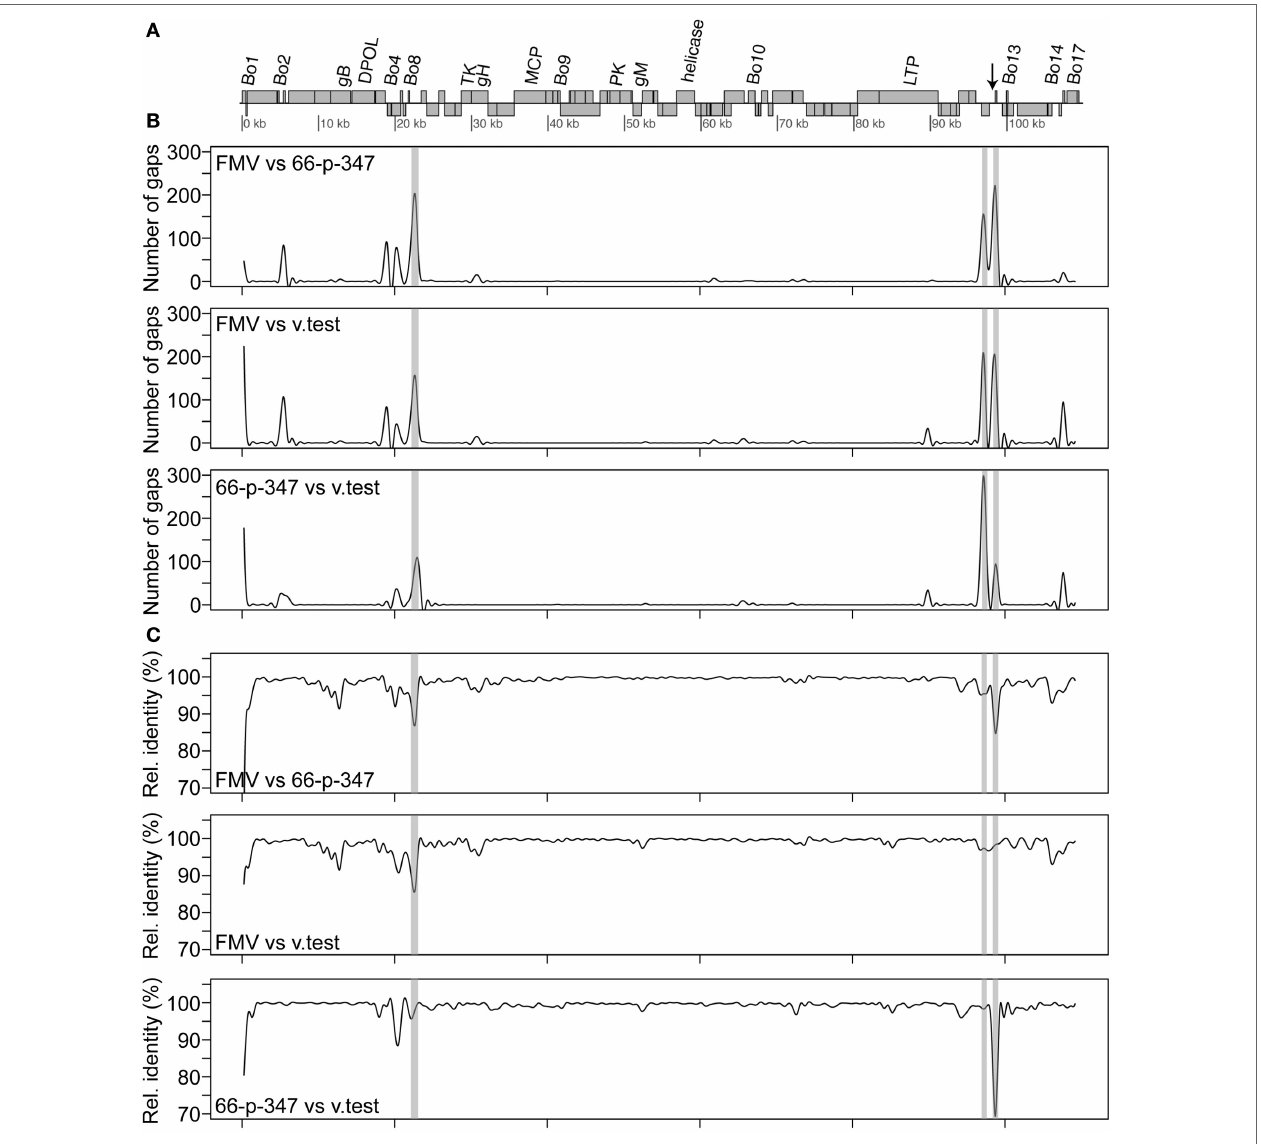
FigUre 2 | Sequence comparison of the bovine gammaherpesvirus 4 (BoHV-4) long unique coding region (LUR) sequences. (a) Map of the BoHV-4 LUR genome. Every open reading frame is illustrated by a gray box. Upper boxes correspond to genes on the + strand, while the others are the genes on the − strand. Only some specific genes are indicated. The arrow indicates the position of the quasi-palindromic motif of the oriLyt region. (B) A pairwise comparison of the number of gaps between the three complete BoHV-4 genome sequences [FMV (BoHV-4-FMV), 66-p-347, and V.test] is shown. (c) A pairwise comparison of the relative identity between the three complete BoHV-4 genome sequences is shown. For both B and C, a 501 bp sliding window was used for the comparison. The gray areas shown in B and C represent the repeat regions (R1, R2a, R2b from left to right) found in the BoHV-4